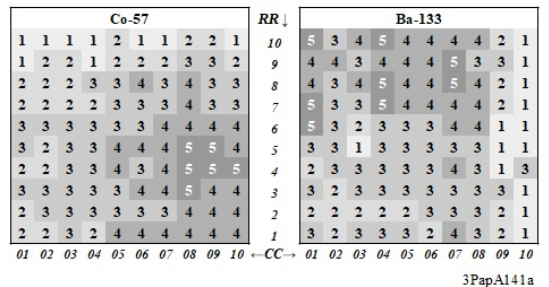
Figure 3. Array maps representing the crystal-pixel’s 2-D distributions per pulse-height cluster from Co-57 ( left ) and Ba-133 ( right ) data-takings. Bin-sizes of 1.2-, and 2.4-charge-units were chosen, re- spectively, for clustering the Qnet values from each irradiation into five groups, which makes the distributions comparable with each other. The coordinates of the pixels in the array were described by using the RRCC codes.